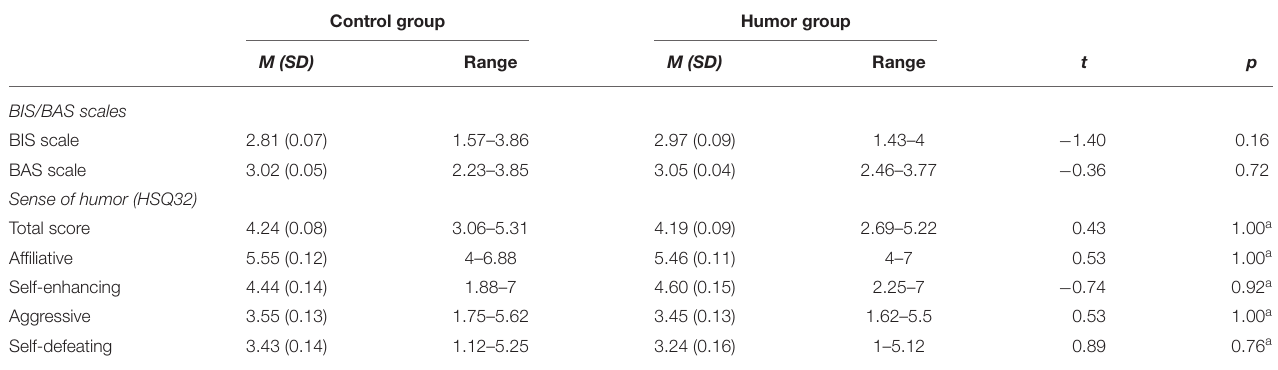
TABLE 3 | Group characteristics with respect to approach and avoidance behavior as well as trait